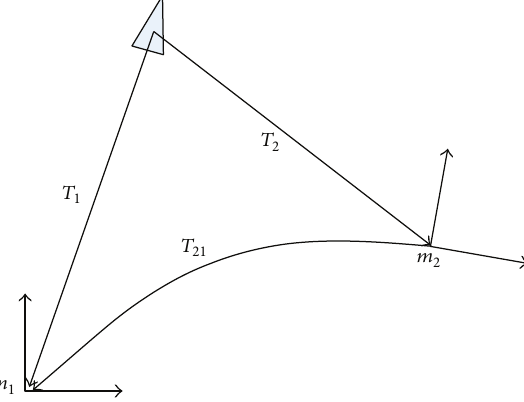
Figure 3: Map merging coordinate